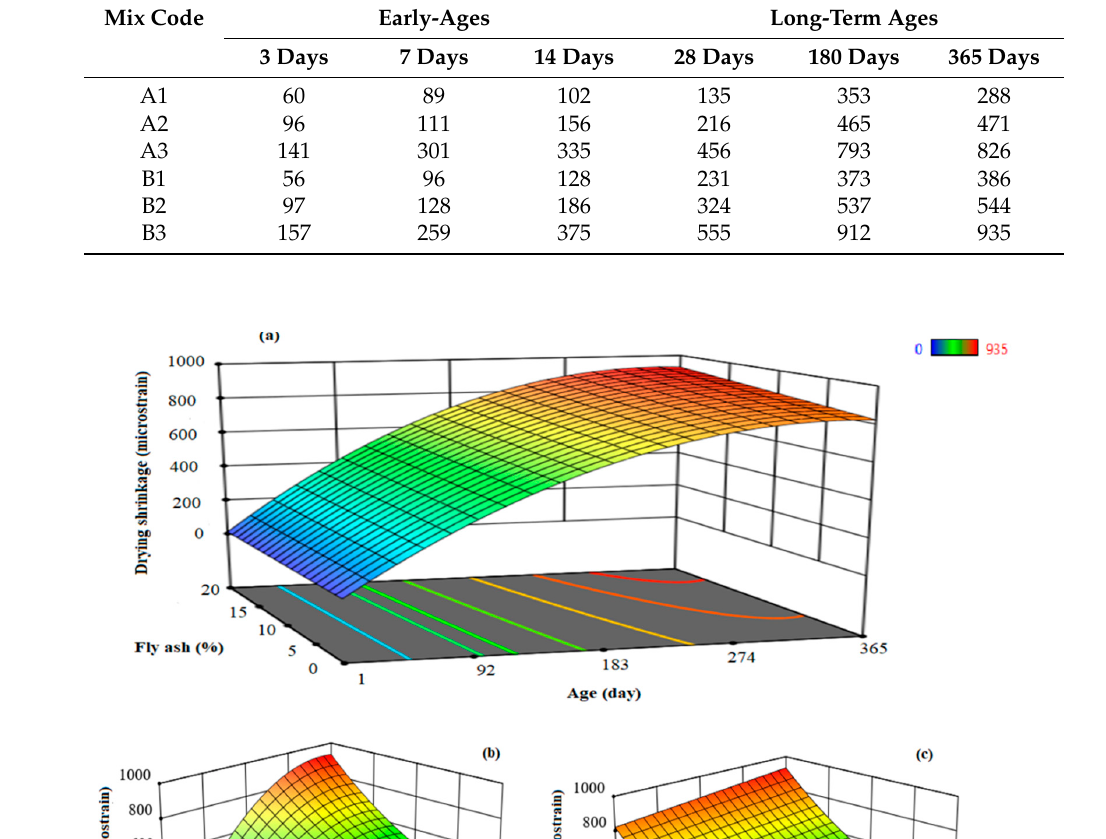
Table 8. Drying shrinkage results under 7 days continuing moist curing.